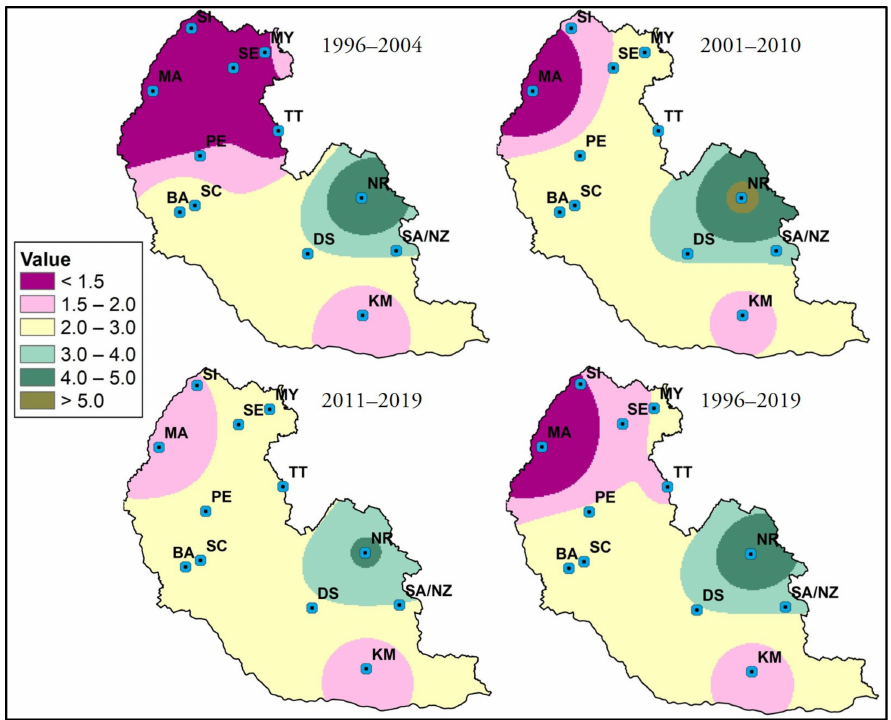
Figure 10. Spatiotemporal variations of Wf and mean Wf for the whole study period by